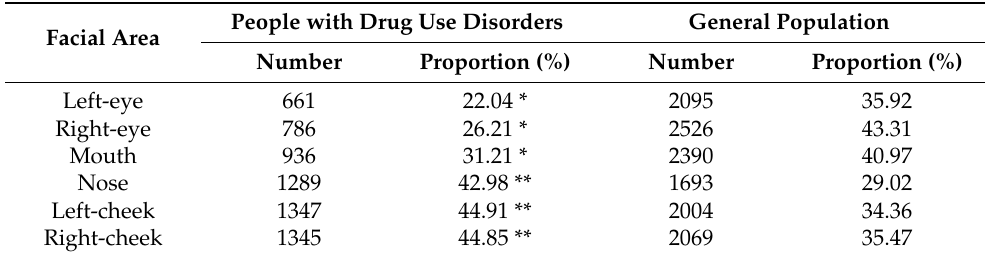
Table 4. Comparison of facial features in people with drug use disorders and the general population. Facial